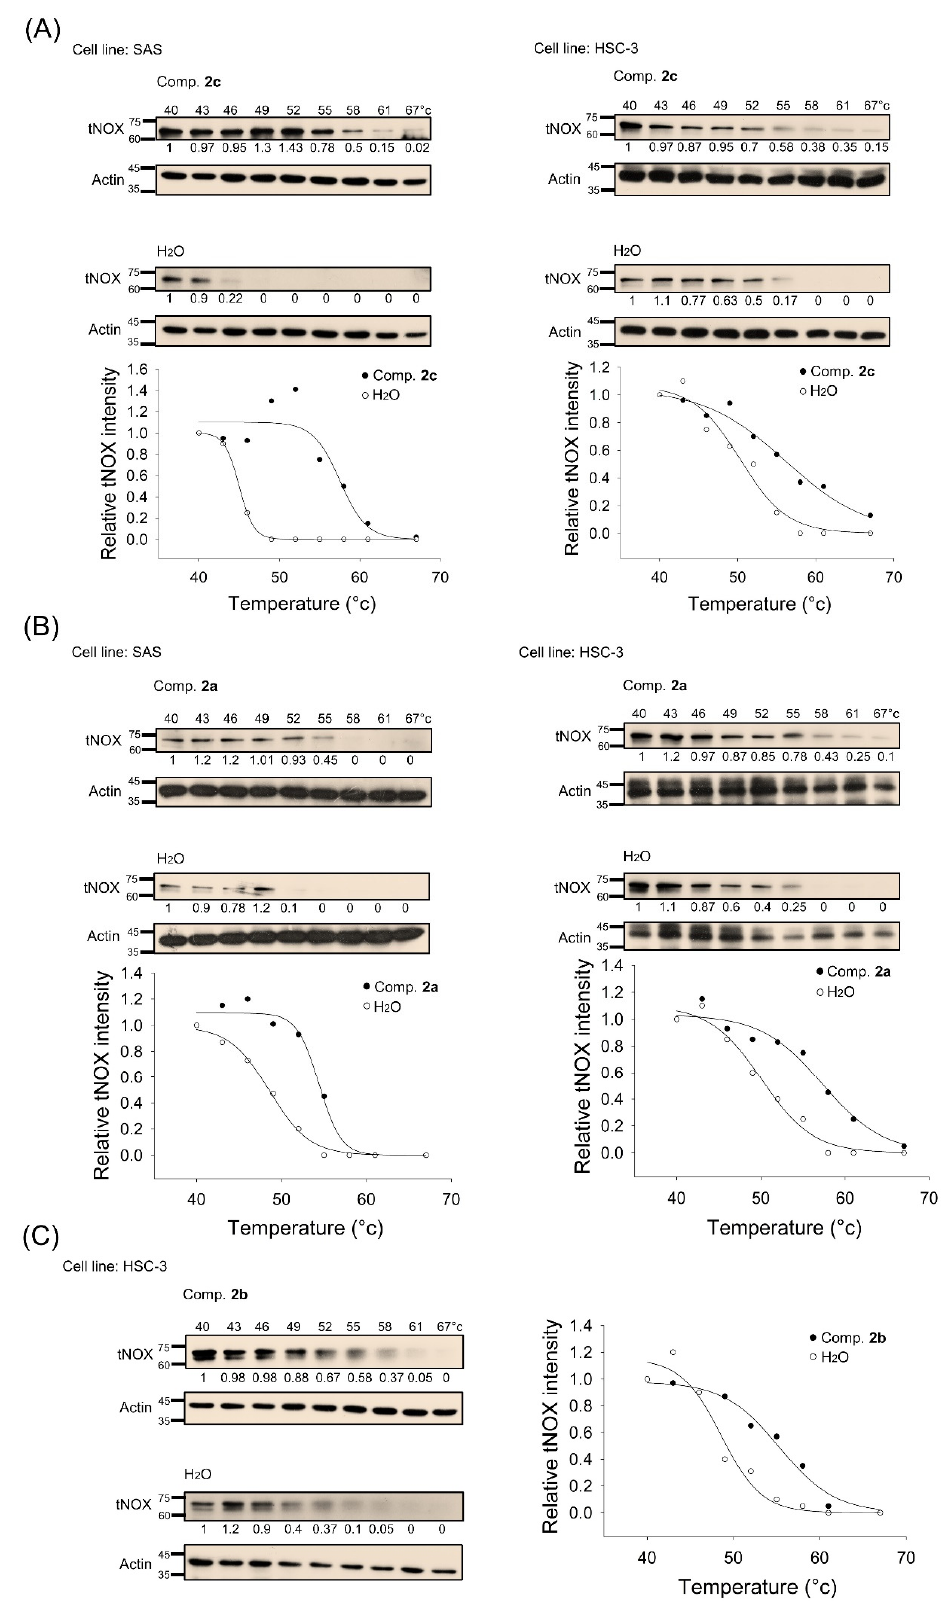
Figure 5. CETSA-based identification of direct binding between tNOX protein and bis(chloroace- tamidino)heteroarene-fused anthraquinones 2a – c . Top panel: the immunoblot intensity of tNOX